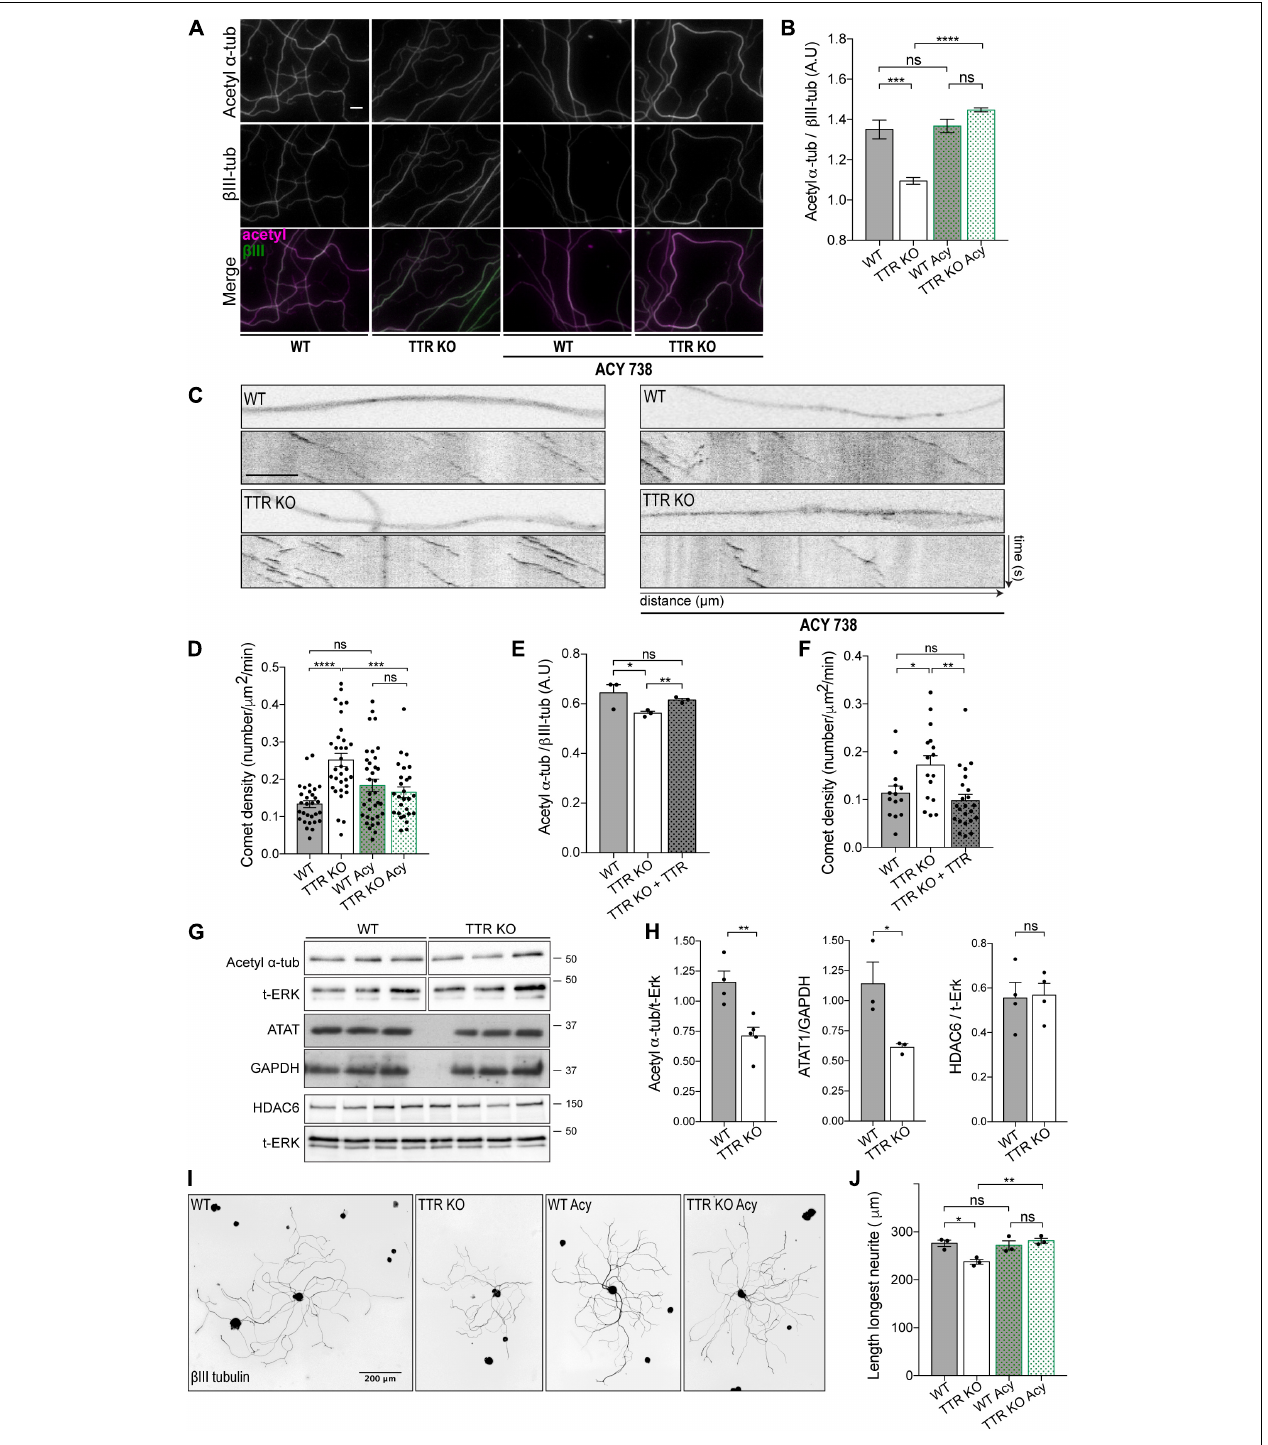
FIGURE 4 | Transthyretin-mediated regulation of MT dynamics and axonal growth occurs via modulation of α -tubulin acetylation. (A) Representative images of acetylated α -tubulin (magenta) and β III-tubulin (green) immunostaining of WT and TTR KO 4DIV DRG cultures untreated and treated with ACY-738. Scale bar: 10 µ m. (B) Quantification of the relative values of acetylated α -tubulin over β III-tubulin. Data represent mean ± SEM ( n = 4 independent samples/condition; 50 axons/sample. Statistical significance determined by One-way ANOVA with Tukey’s multiple comparisons test: *** P < 0.001; **** P < 0.0001, ns, not significant. (C) Representative still images of the axonal shafts from DIV4 WT-Thy1-EB3-YFP (WT) and TTR KO-Thy1-EB3-YFP (TTR KO) DRG neurons either untreated or treated with ACY-738 and correspondent kymographs. Scale bar: 5 µ m. (D) Quantification of comet density in neurite shafts from DIV4 WT-Thy1-EB3-YFP and TTR